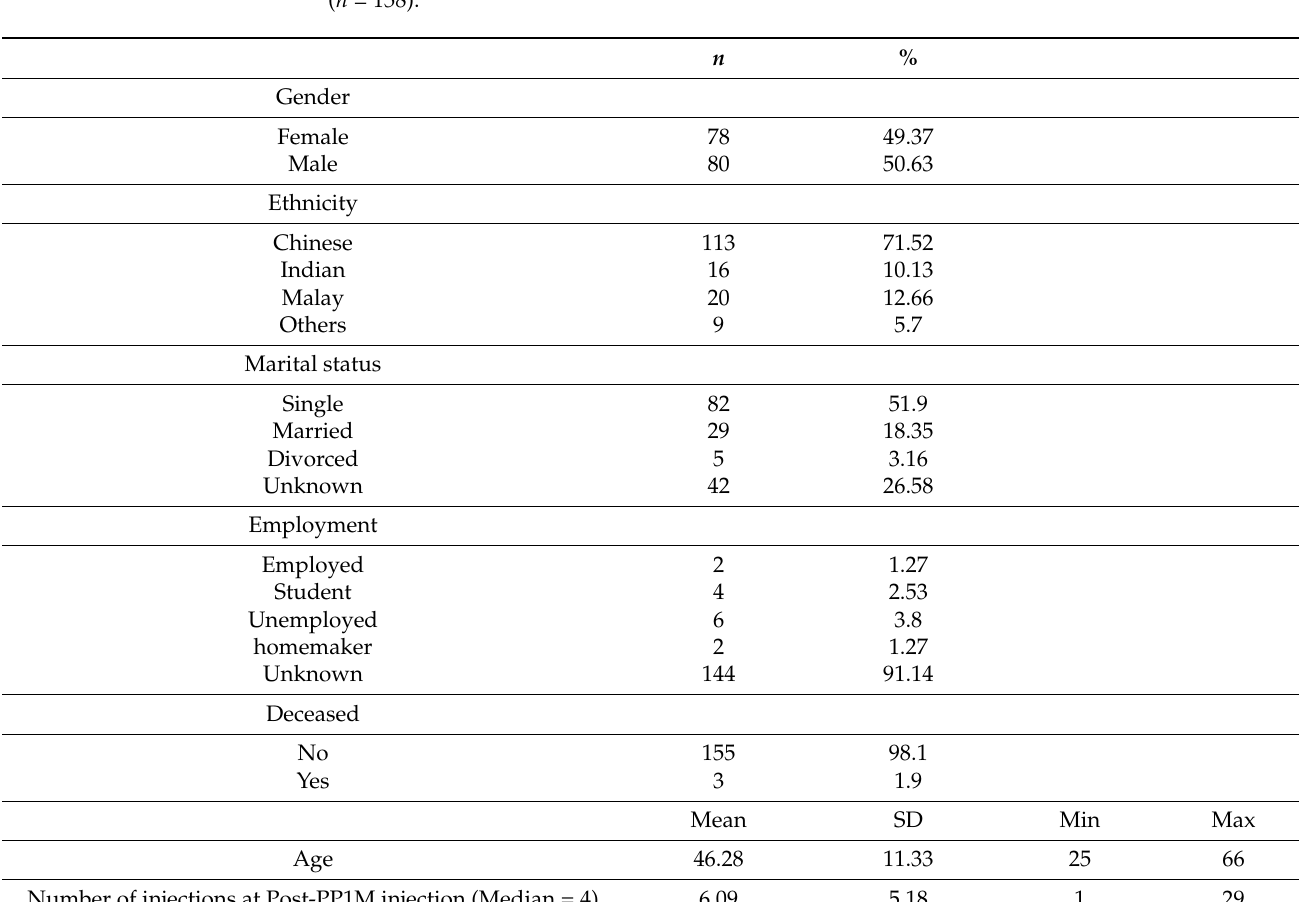
Table 1. Sociodemographic characteristics of patients with schizophrenia spectrum disorders ( n = 158).